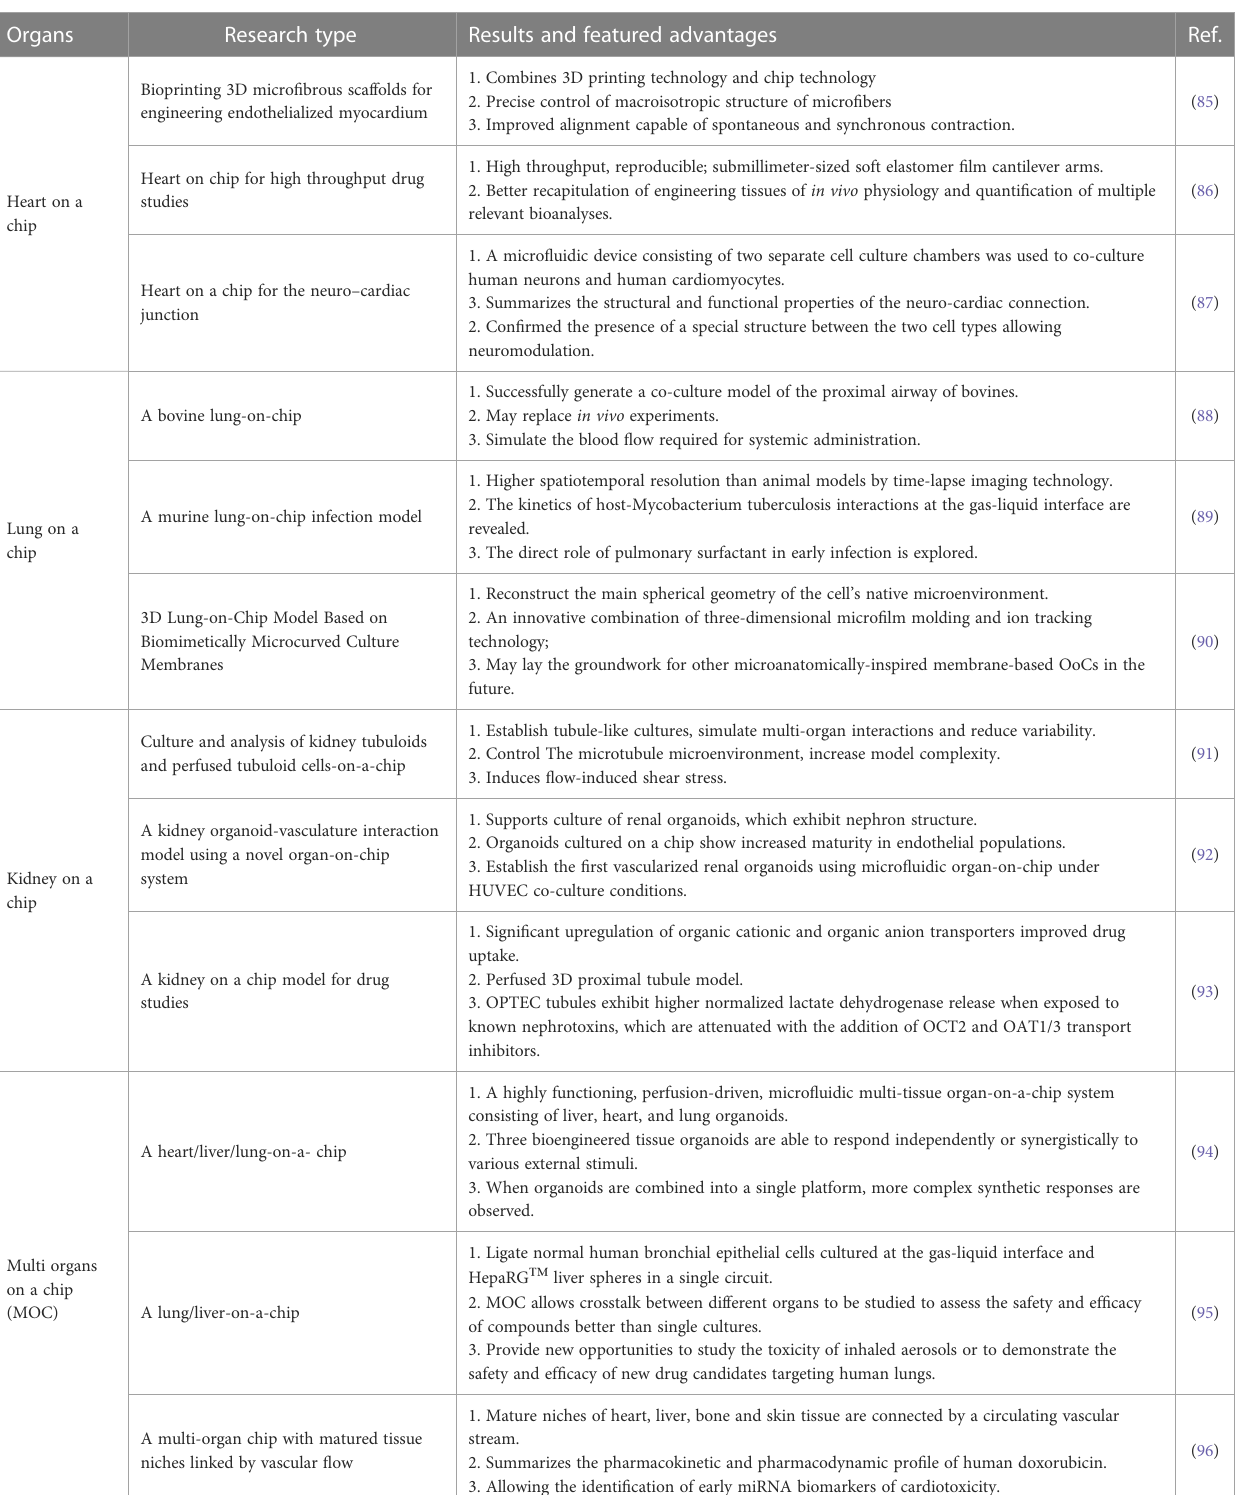
TABLE 3 Summary of the major organ on chip